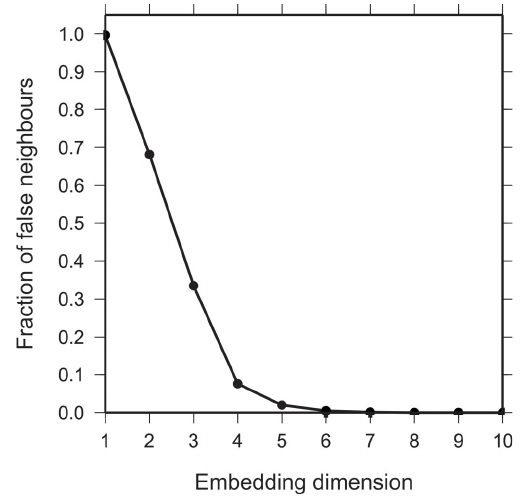
Fig. 6. Diagram showing the distribution of the percentage of false nearest neighbors as a function of the embedding dimension for event